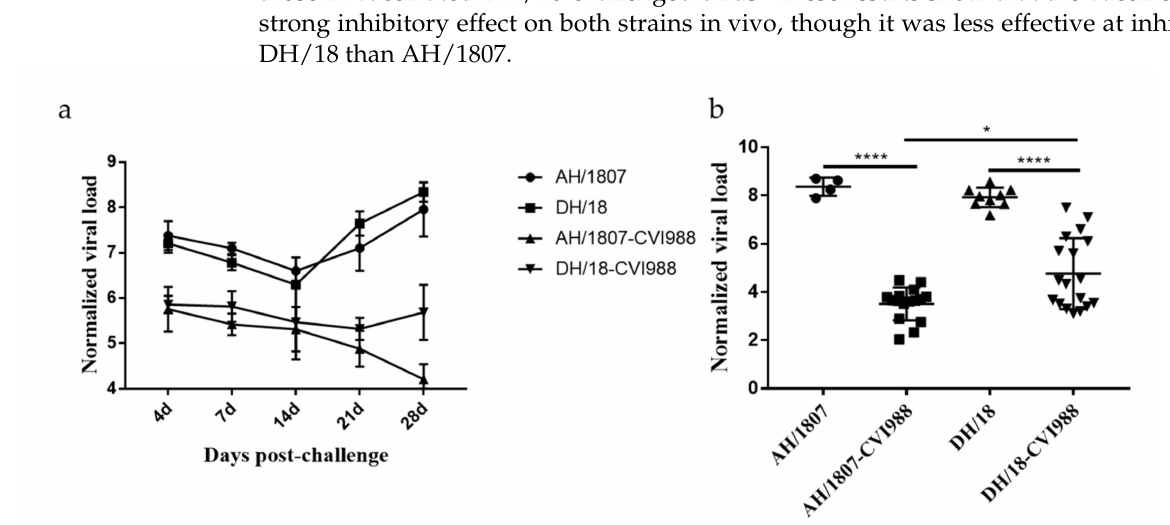
Figure 6. Normalized viral loads in the spleens of chickens from various treatment groups. ( a ) The normalized viral loads from the spleens of three chickens randomly selected from each group at 4-, 7-, 14-, 21-, and 28-days post challenge (dpc). ( b ) The normalized viral loads in the spleens of all surviving chickens in each group at 72 dpc. Normalized viral loads were calculated as the logarithm of the MDV copy number per million cells. T tests were performed for significance analysis. The data are shown as means with standard deviations (SDs). * p < 0.05, **** p <